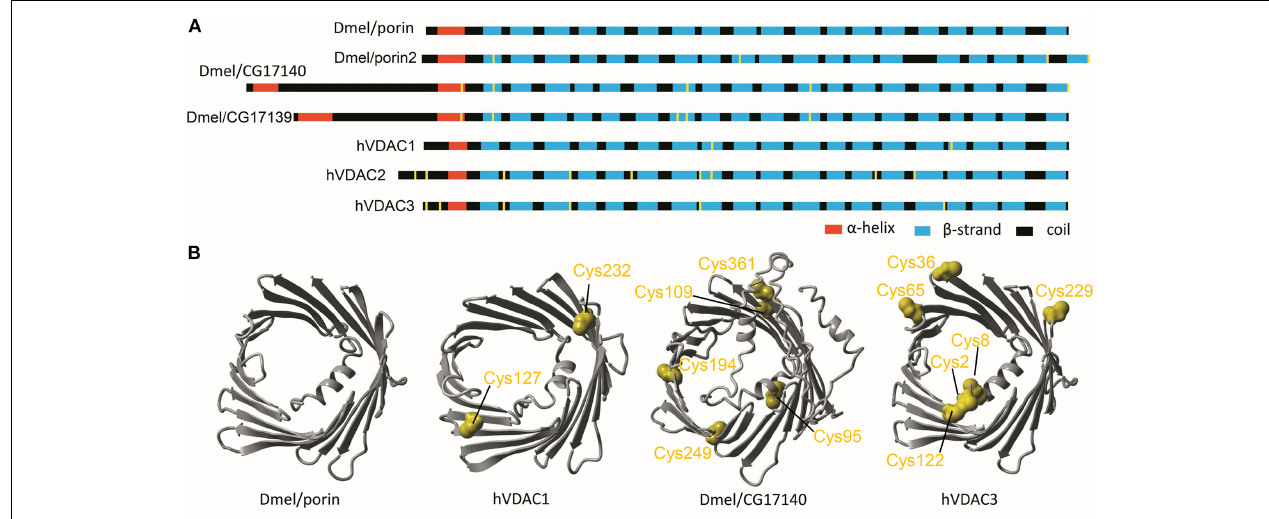
FIGURE 3 | Drosophila melanogaster and human VDAC paralogs as models in studies of redox-sensitive VDAC. (A) The secondary structure of D. melanogaster and human VDAC paralogs with cysteine residues marked in yellow. (B) The tertiary structure predicted for ubiquitously expressed D. melanogaster and human paralogs (Dmel/porin and hVDAC1, respectively) as well as for paralogs with limited expression, mainly in D. melanogaster male reproductive tracts and human testes (Dmel/CG17140 and hVDAC3, respectively). Cysteine residues are marked in yellow.